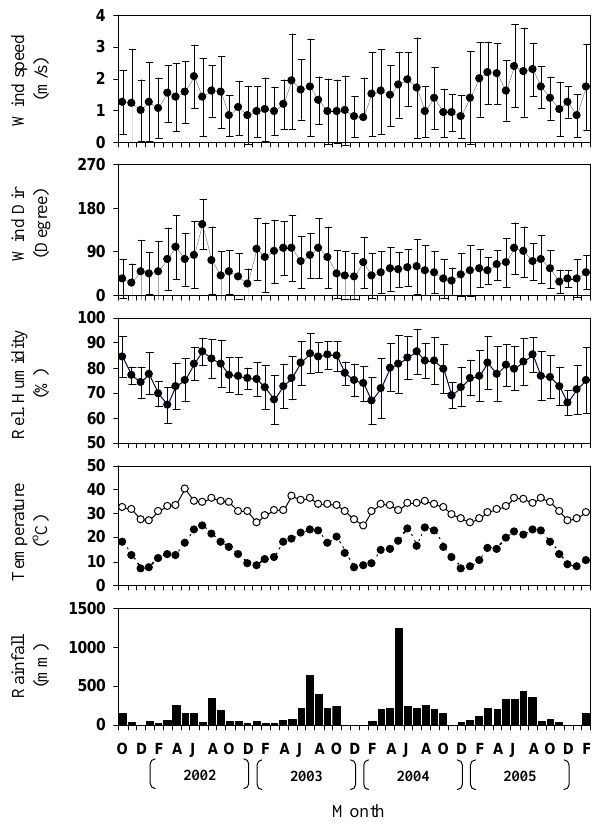
Figure 2 : Monthly variation of (a) surface wind speed (b) surface wind direction, (c) Relative Fig. 2. Monthly variation of (a) surface wind speed (b) surface humidity (d) maximum and minimum temperature and (e) monthly total rainfall respectively wind direction, (c) relative humidity, (d) maximum and minimum from October 2001 to February 2006. The vertical bars represent the standard errors temperature and (e) monthly total rainfall, respectively, from Octo- ber 2001 to February 2006. The vertical bars represent the standard errors.